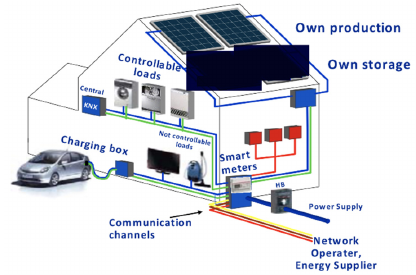
Figure 2. Local production of electricity.